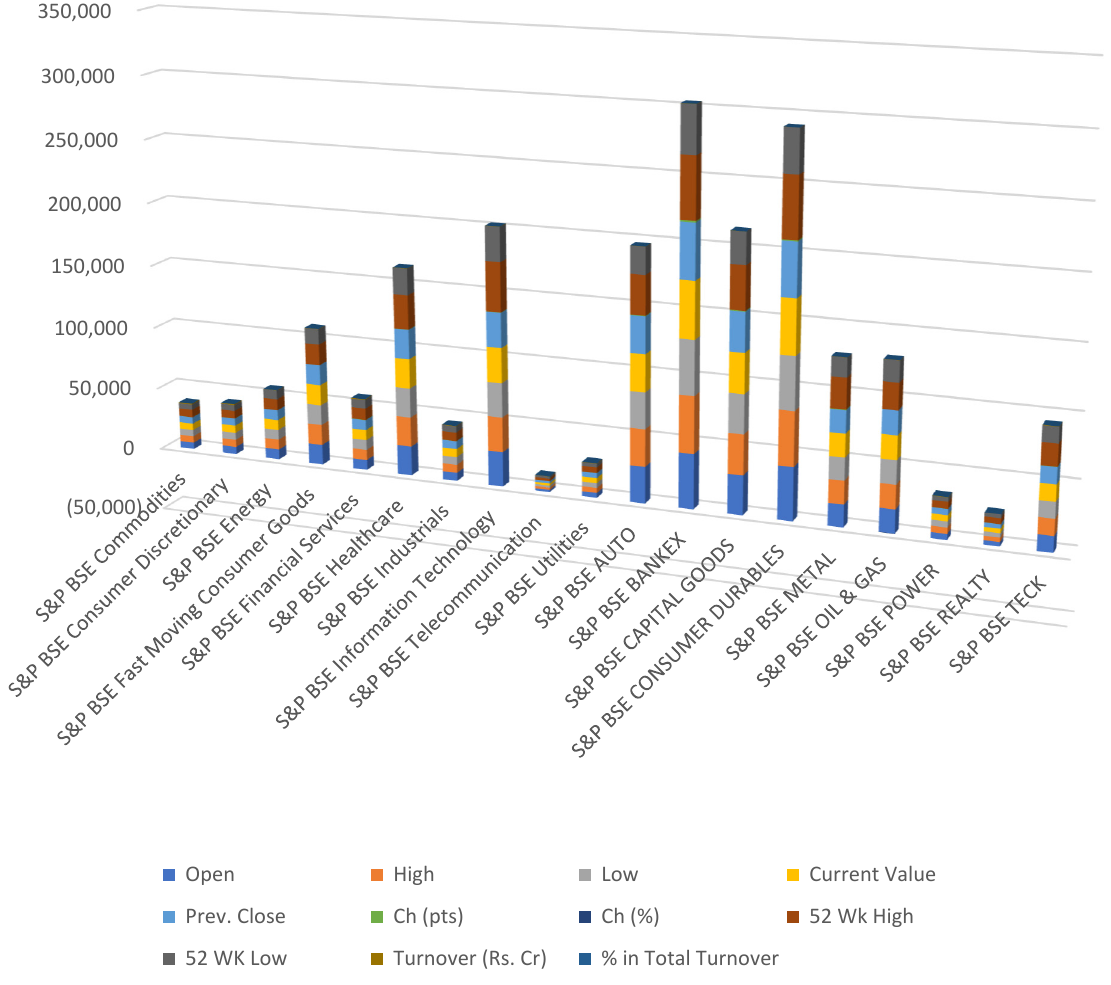
Figure 2. BSE Sectoral Index Performance. Source: https://www.bseindia.com/Sensex/IndexHighlight.html?type=4 (accessed on 2 October 2022 [93].